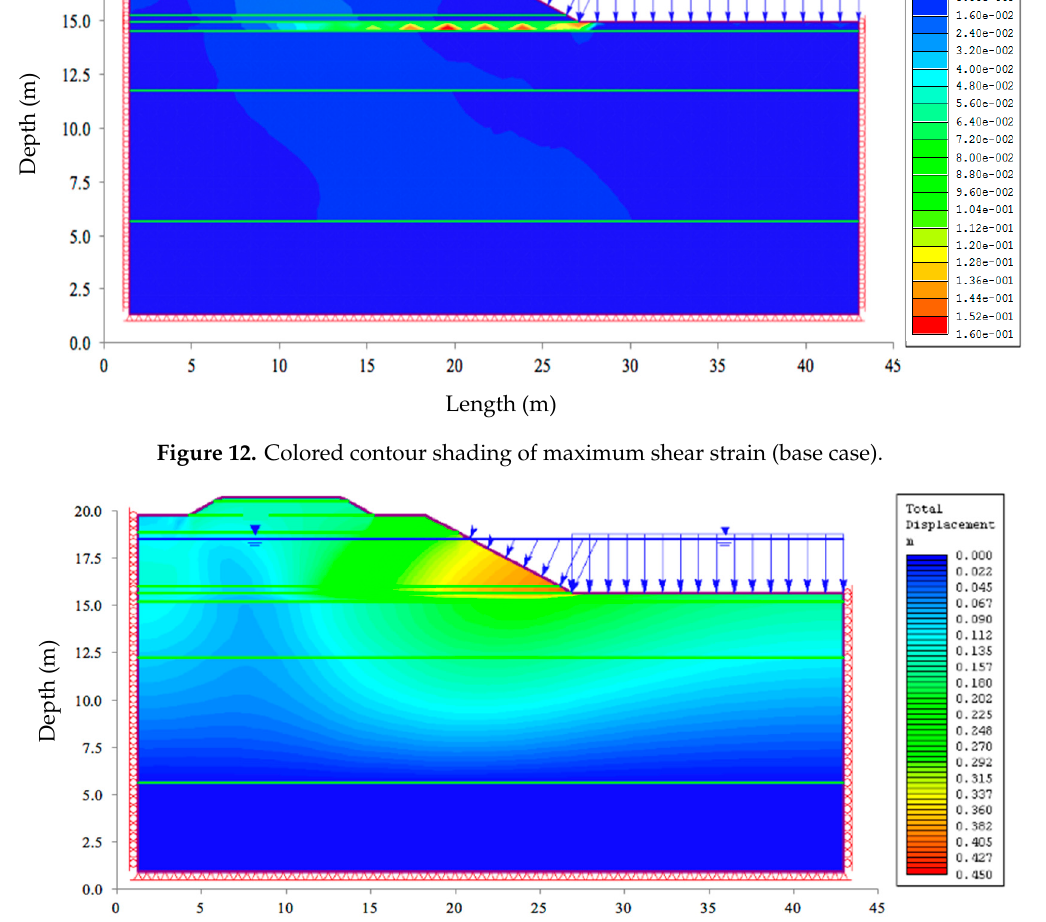
Figure 13. Colored contour shading of the total displacement (base case).